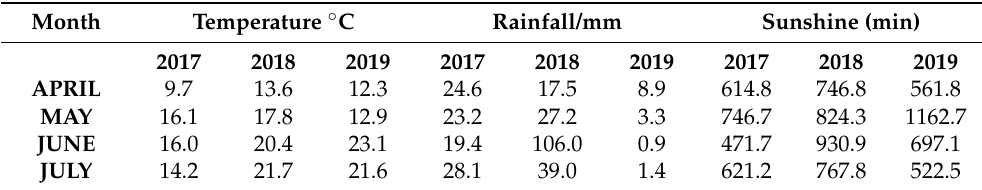
Table 7. Meteorological data during growing season of eleven varieties of white lupin within years 2017/2018/2019 in the Research Institute of Plant Production in